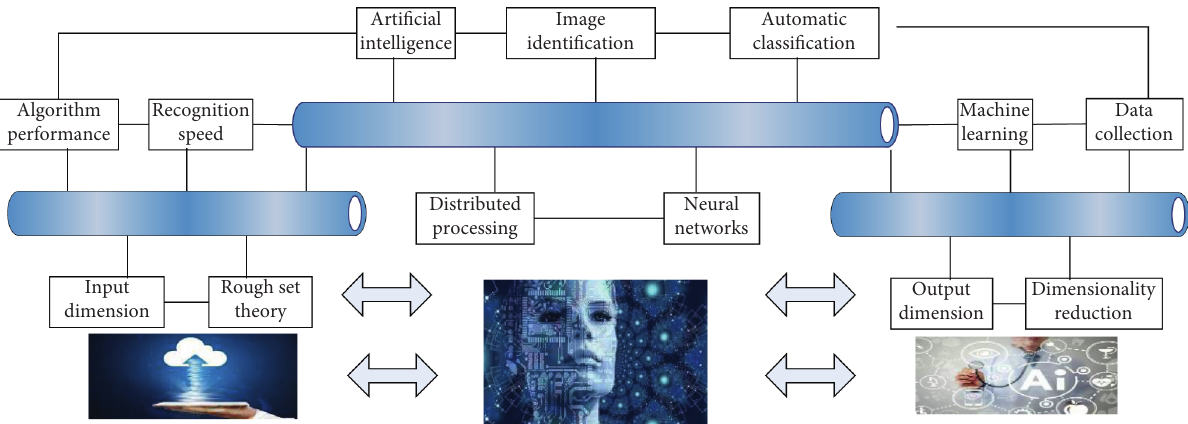
Figure 1: Hierarchical analysis of image recognition under artificial intelligence.